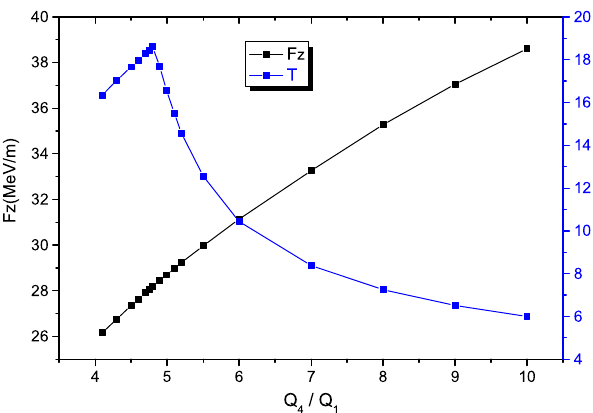
FIG. 8. Transformer ratio (blue symbols) and accelerating gradient (black symbols) versus the ratio of the last bunch charge to the first bunch charge. The other parameters of the bunch train and the CDWA are the same as in Fig. 6.